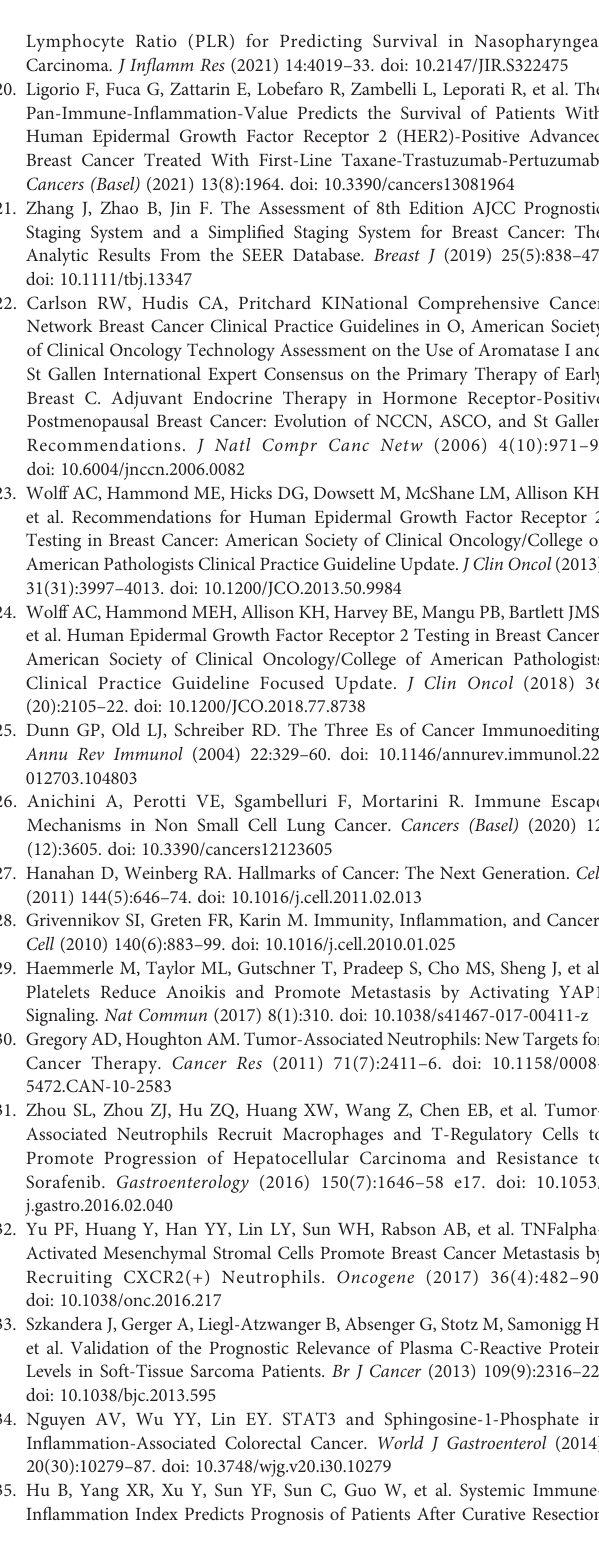
SupplementaryFigure5 | Kaplan-Meier survival curves of breast cancer patients after surgery between the high-NLR group and low-NLR group in the whole cohort.